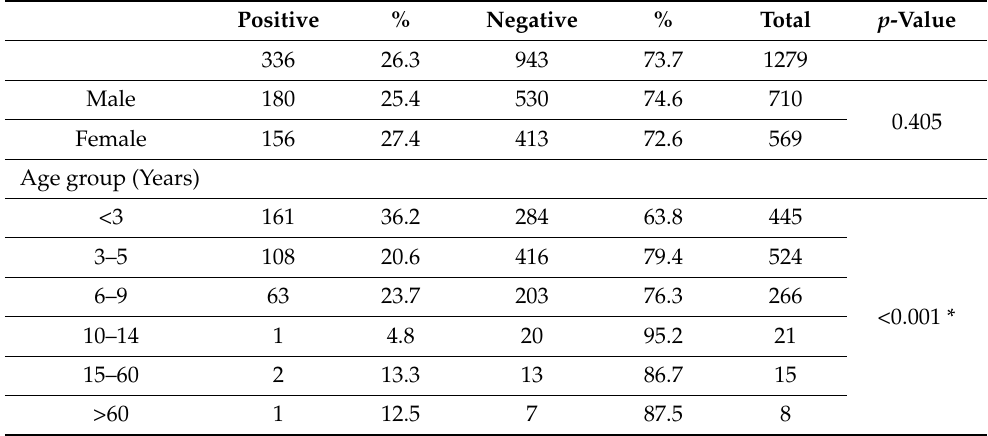
Table 2. The rate of RSV infection according to gender and age group.